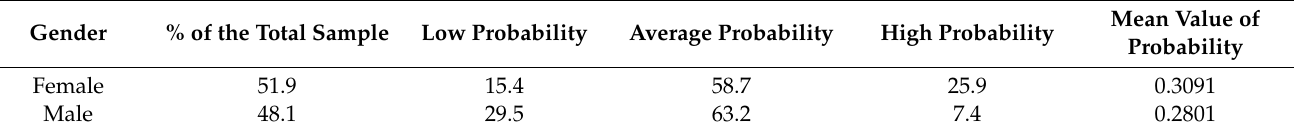
Table 4. Relationship between gender and the estimated probability of visiting the Monfragüe